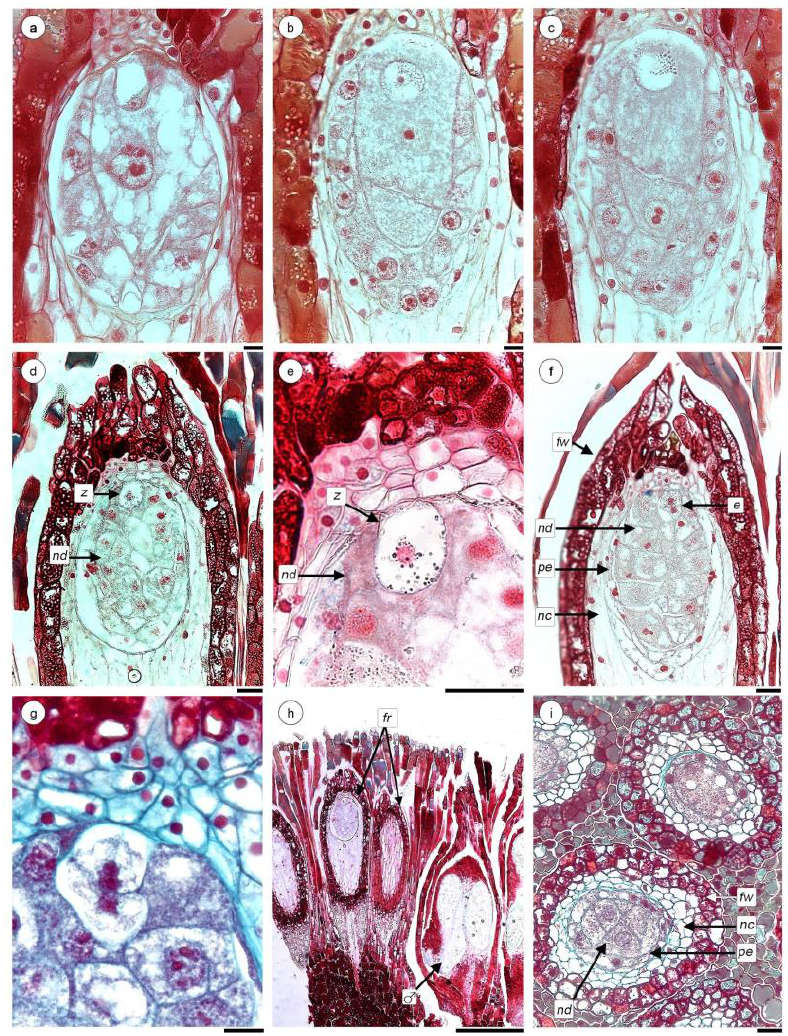
Figure 5 . Embryo and endosperm of H. cayennensis development. ( a ) Vacuolized embryo sac. ( b – c ) Cytokinesis in central cell. ( d ) Longitudinal sections (LS) of fruit with endosperm and zygote. ( e ) Detail of zygote. ( f ) Bicellular embryo and multicellular endosperm. ( g ) Detail of bicellular embryo and surrounded endosperm cells. ( h ) LS of inflorescence with fruit and male flower still not anthetic. ( i ) Transection of fruits. Abbreviations: e: embryo; fr: fruits; fw: fruit wall; nc: nucellar complex; nd: endosperm; pe: pseudo-endothelium; ♂ : male flower; z: zygote. Scales bar = ( a – c, g) 20 µm; ( d – f, i ) 50 µm; ( h ) 0.5 mm.